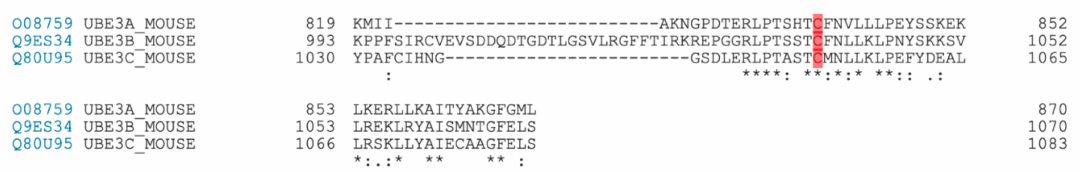
Figure 1. Sequence alignment of the C-termini of Ube3 ligases (Uniprot accession numbers on the left). Numbers on the left and right indicate the extreme amino acid positions. Highlighted in red is the active site catalytic cysteine. Symbols “*”, “:”, “.”, denote the degree of single residue